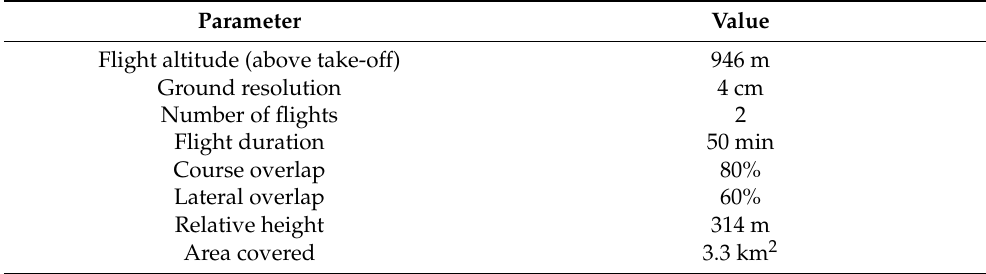
Table 1. The flight parameters of the aerial image acquisition. Parameter Value Flight altitude (above take-off) 946 m Ground resolution 4 cm Number of flights 2 Flight duration 50 min Course overlap 80% Lateral overlap 60% Relative height 314 m Area covered 3.3 km 2